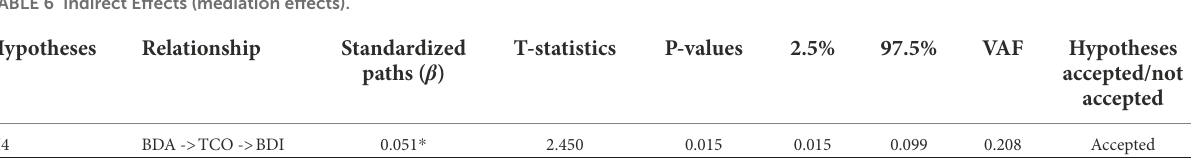
TABLE 6 Indirect Effects (mediation